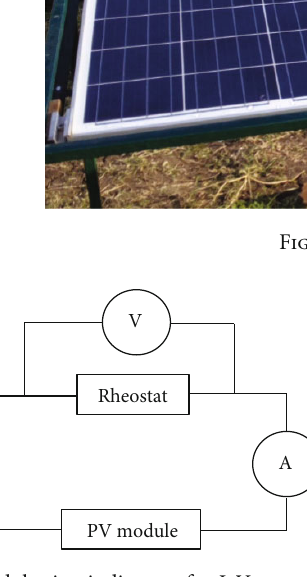
Figure 4: PV module circuit diagram for I ‐ V curve